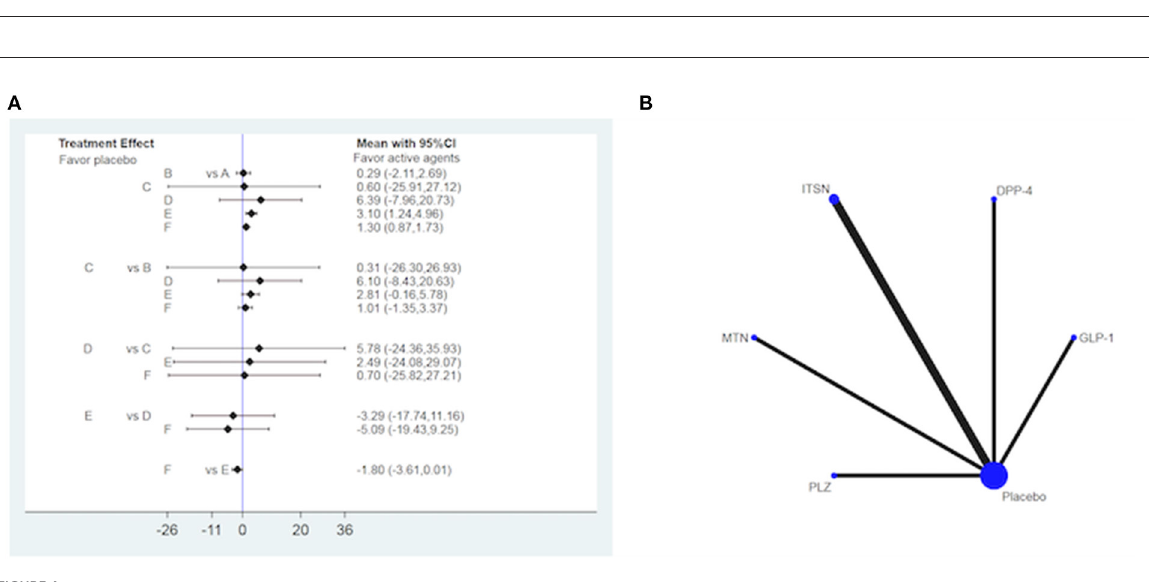
FIGURE4 Forest plot (A) and network map (B) for hypoglycemic drugs (HD) with placebo in improving A β 42. (A) A: placebo, B: intranasal insulin, C: metformin, D: pioglitazone, E: glucagon-like peptide-1, F: dipeptidyl peptidase 4 inhibitor. (B) Lines connect the interventions that have been studied in head-to-head comparisons in eligible RCTs. The width of the lines represents the total number of RCTs for each pairwise comparison. The size of each node is proportional to the number of randomized participants. Metformin (MTN), Pioglitazone (PLZ), Intranasal insulin